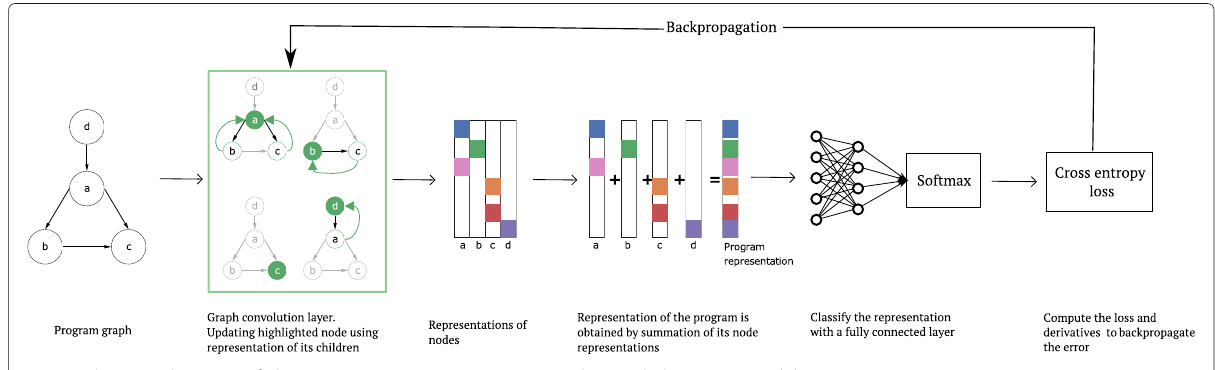
Fig. 4 Schematic depiction of obtaining a program representation with a single-layer GCN model